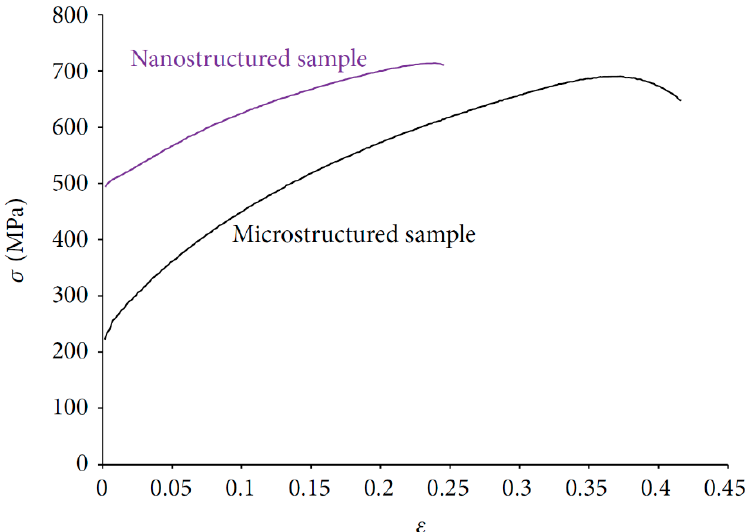
Figure 9. Tensile curves of micro- and nanostructured Ni materials elaborated by SPS [43]. Repro- duced with permission from Journal of Nanomaterials , published by Hindawi, 2013.